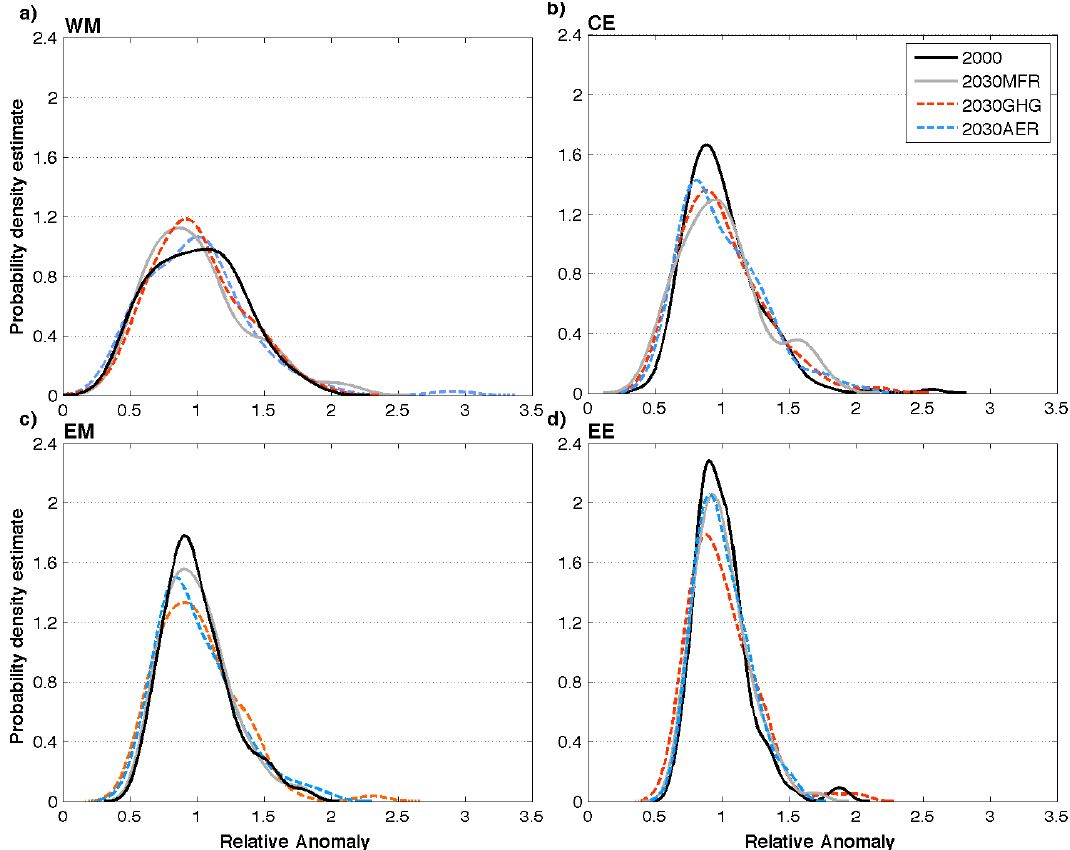
Figure 5. Probability density estimates (PDEs) of PM relative anomalies for each region (Western (a) and Eastern Mediterranean (c) , Central (b) and Eastern Europe (d) ) and for each experiment. Relative anomalies are computed as the ratio between winter (DJF) monthly time series and the winter (DJF) climatology of each experiment and region. The probability density estimates are based on a normal kernel function, which provides non-parametric PDEs for random variables (Rosenblatt, 1956). The probability for a given relative anomaly to occur is obtained by integrating the PDE in d x